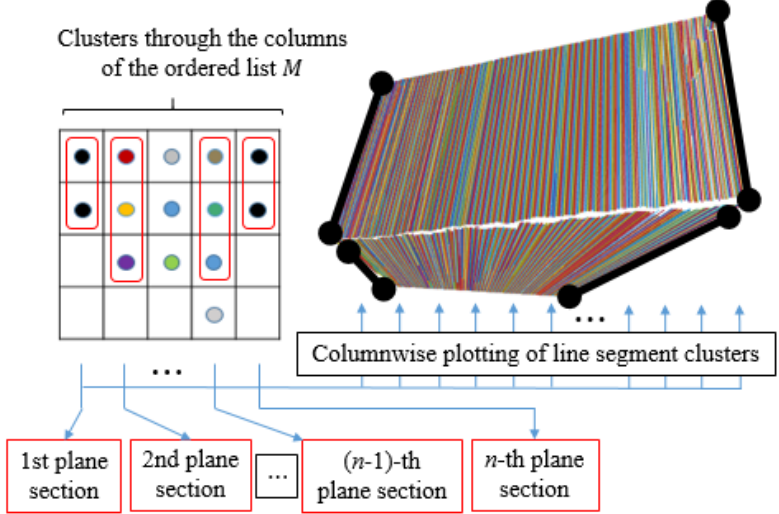
Figure 16. List M of ordered line segments and their visualization. So called columns of the list represent line segments lying on individual planar sections and are determined by their endpoints.